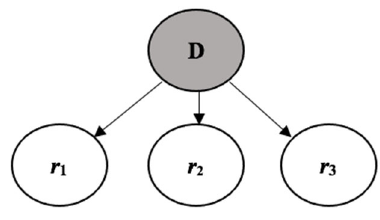
Figure 6. Theistic Multiple Location.